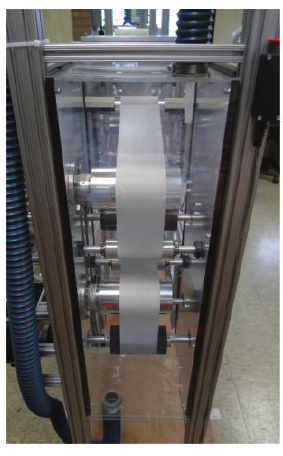
Figure 3: Coated and uncoated membrane roll storage.